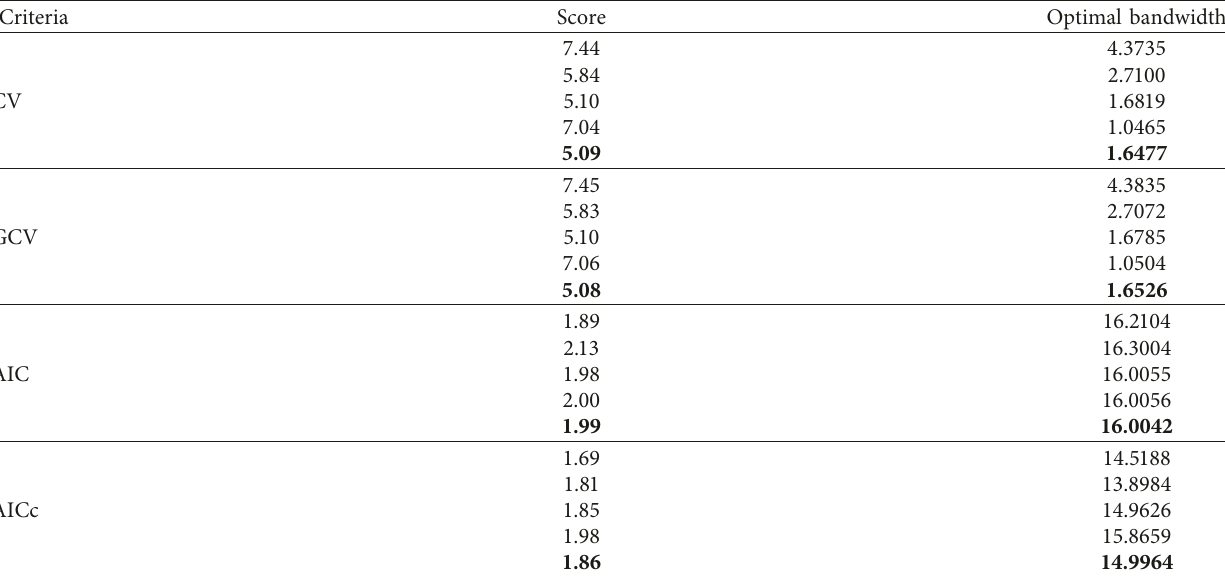
Table 5: Optimal bandwidths for the total fertility rate